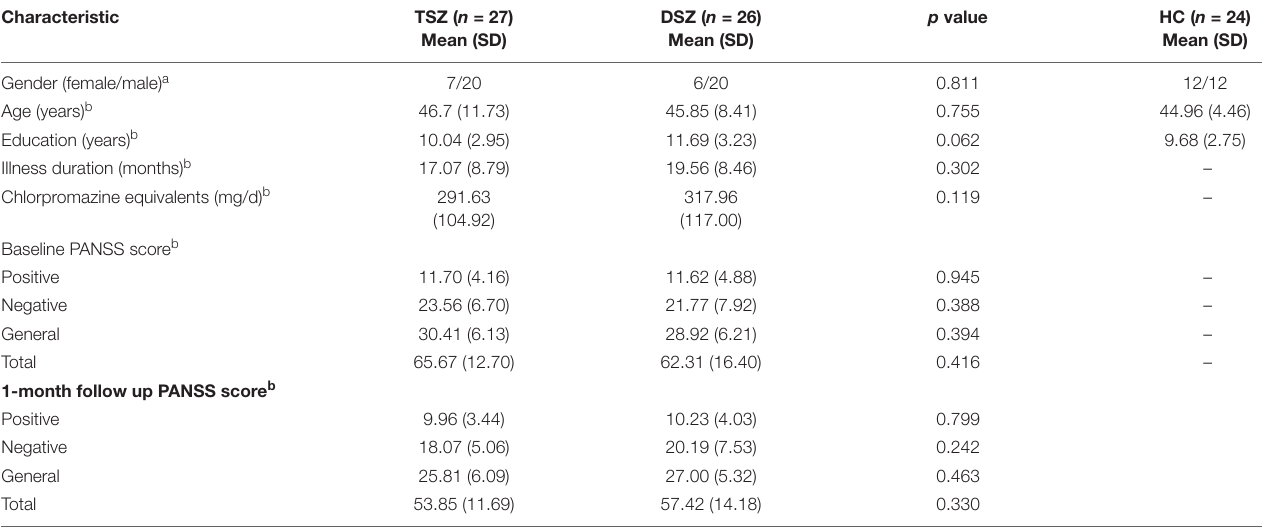
TABLE 1 | Participants’ fundamental information.